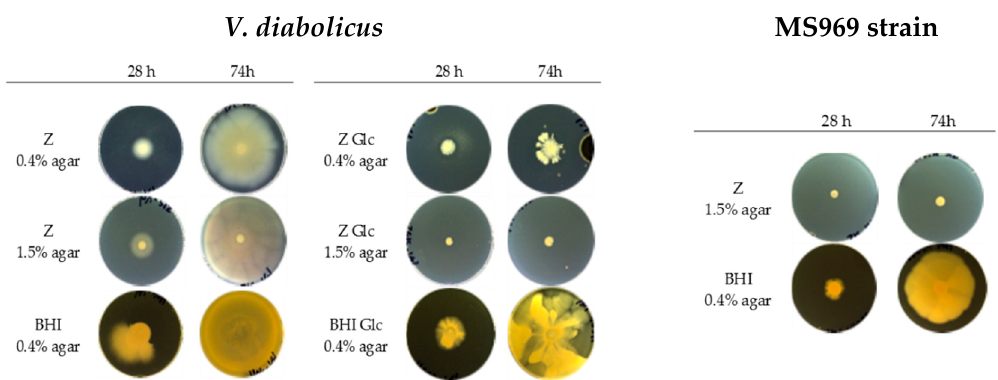
Figure 9. Mobility assays on media containing agar at two concentrations. Z: Zobell medium; Glc: 30 g/L glucose.